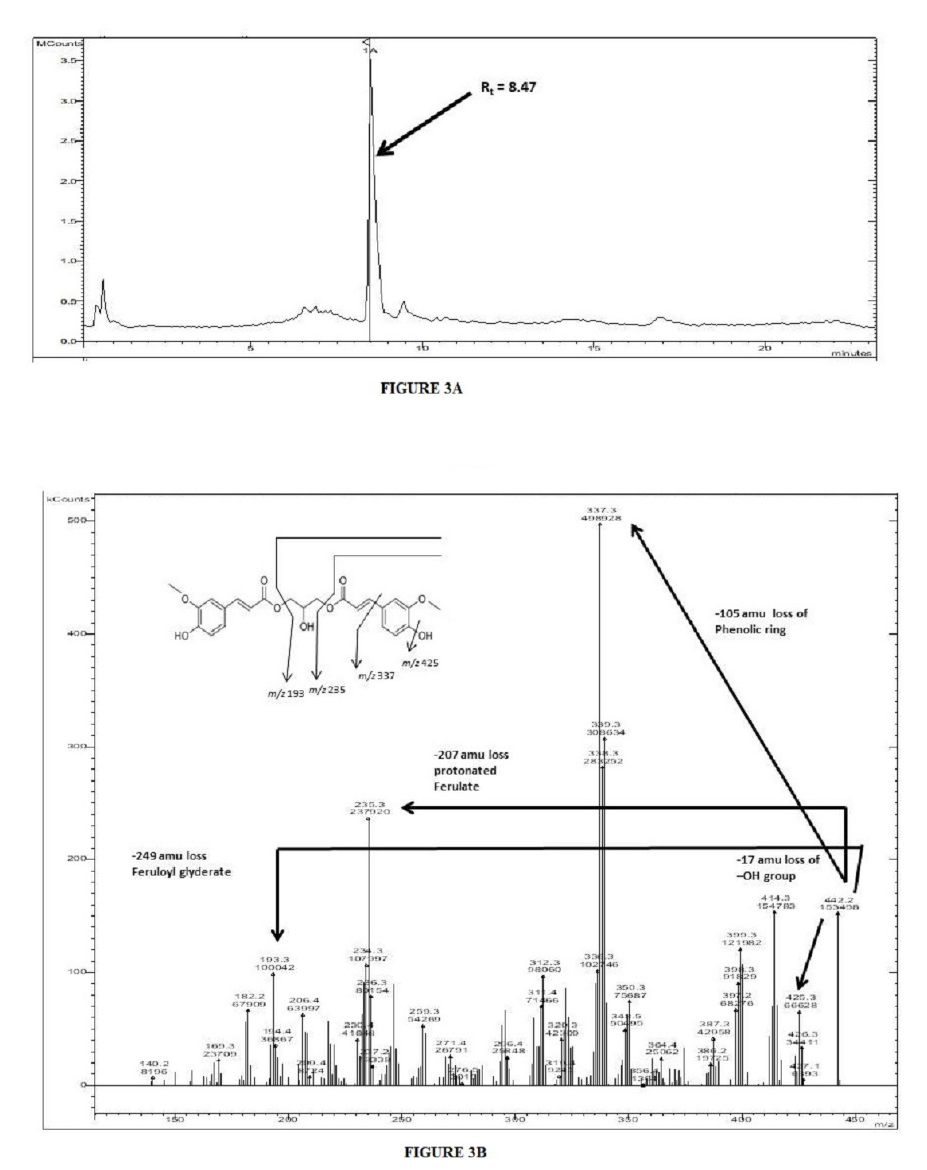
FIGURE 3 - (A): HPLC analysis of PTLC eluate; (B): MS 2 analysis and fragmentation pattern of PTLC